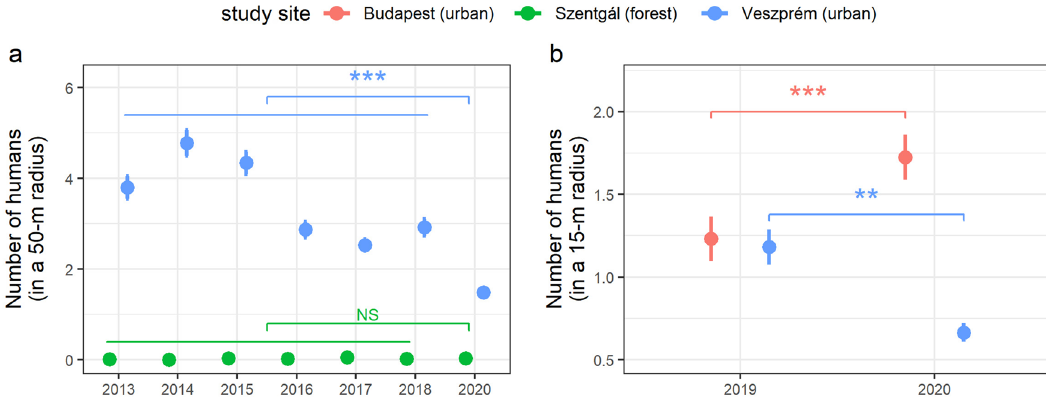
Figure 1. The number of humans (mean ± SE) recorded for 30-s counts in the proximity of active great tit nests during nest checks at ( a ) the forest (Szentgál) and urban (Veszprém) study sites in 2013–2018 (reference period) and 2020 and at ( b ) the two urban study sites (Budapest and Veszprém) in 2019–2020. Results are from linear models’ estimates (mean ± SE). Differences were statistically compared between 2020 (lockdown period) and the reference period: ( a ) 2013–2018 or ( b ) 2019 (***: 0 > P > 0.001; **: 0.001 > P > 0.01; *: 0.01 > P > 0.05), see main text for the results. The number of humans was recorded either within 50 m ( a ) or 15 m ( b ) (see Methods for